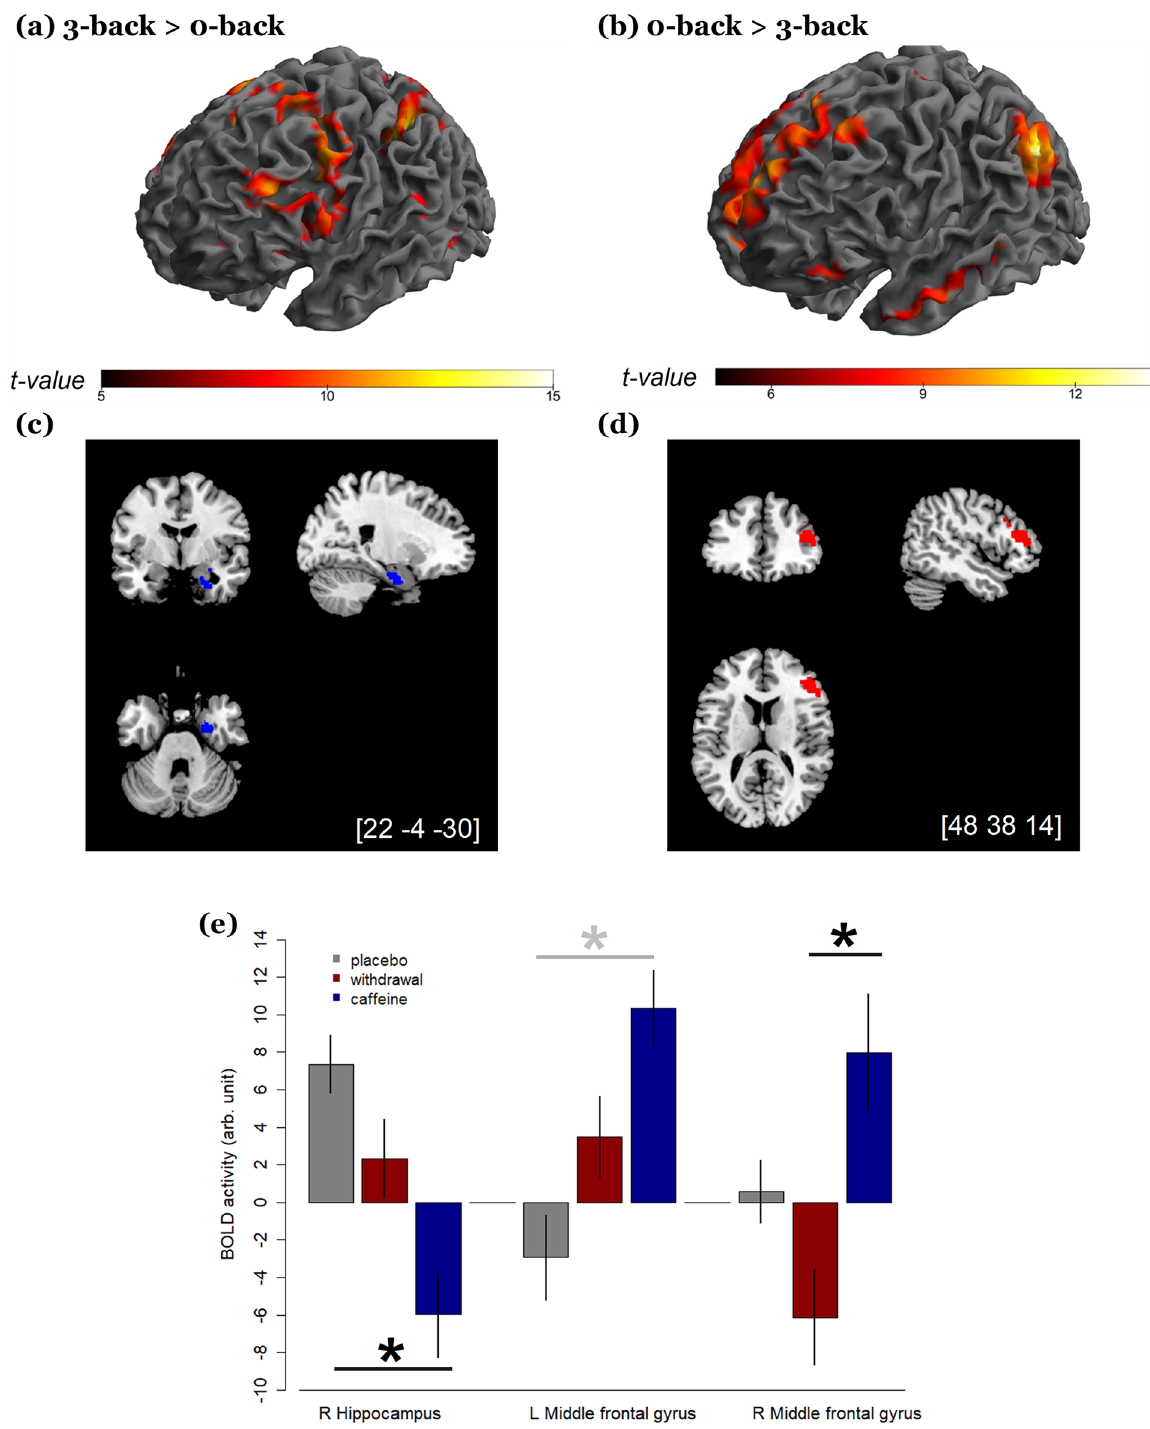
Figure 3. The effects of workload and conditions on blood-oxygen-level-dependent (BOLD) activity. ( a ) brain regions showing increased activities during 3-back compared to 0-back. (b) brain regions showing decreased activities during 3-back compared to 0-back. (c) blue color indicates the location of reduced right hippocampal BOLD activity ( p FWE < .05) during daily caffeine intake compared to placebo. (d) red color indicates the location of increased BOLD activity ( p FWE < .05) in the right middle frontal gyrus during daily caffeine intake compared to withdrawal. (e) Eigenvariates of the significant clusters in hippocampus and left and right middle frontal gyri. The black asterisks and black lines indicate the statistically significant contrast, while the grey asterisk and the grey line indicate the contrast only exhibited at trend